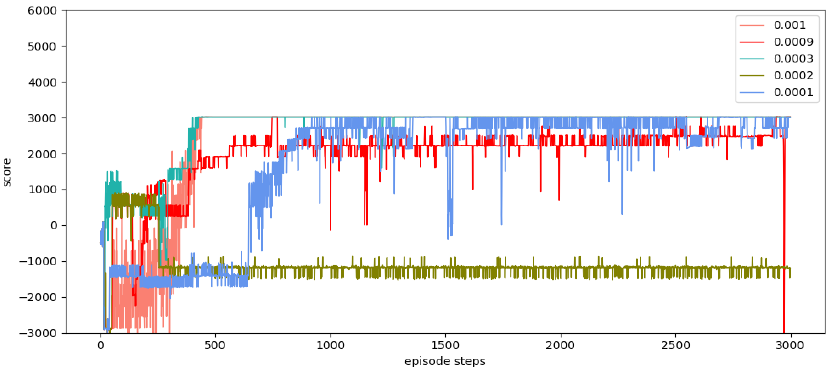
Figure 7. Training result of SD-TD3 (6) algorithm model in environment 1.